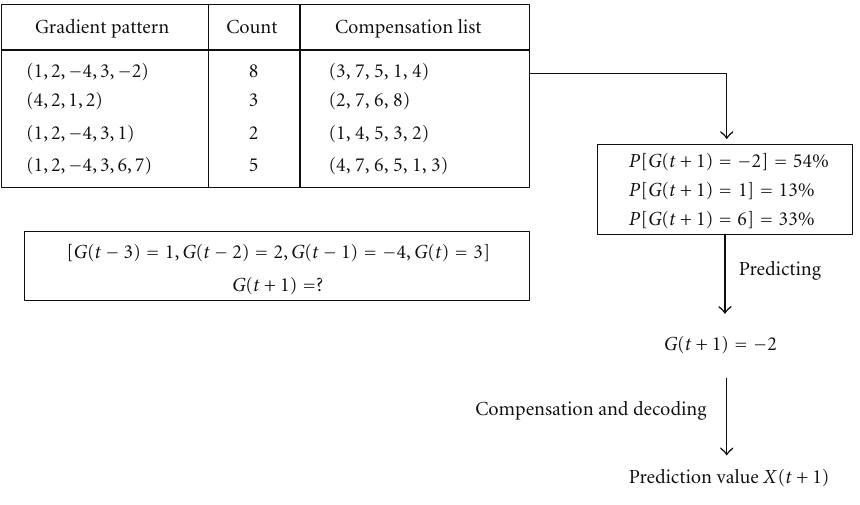
Figure 3: An example of performing